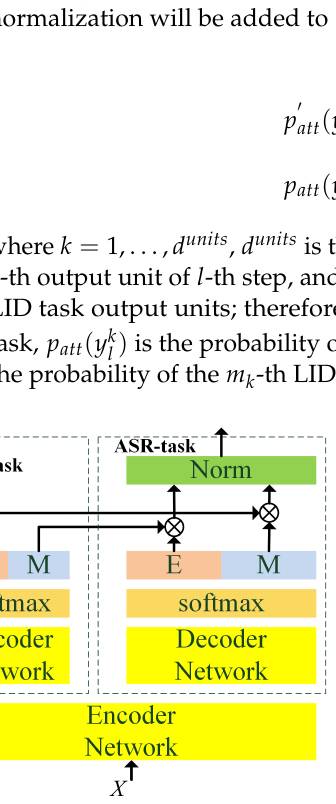
Figure 6. Frameworks for joint LID and ASR decoding.